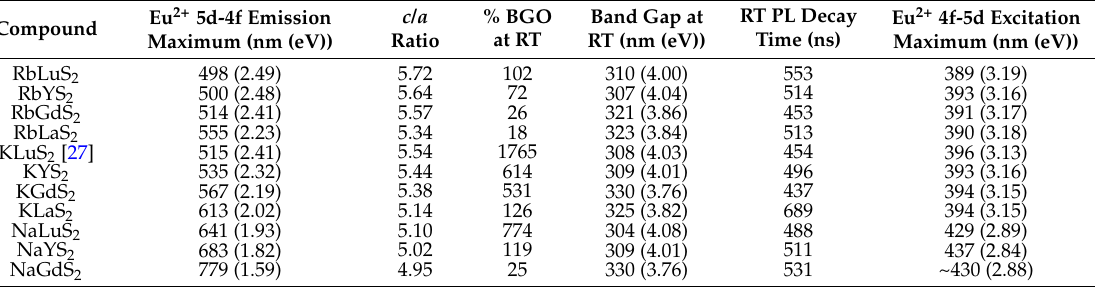
Table 3. Optical properties of ALnS 2